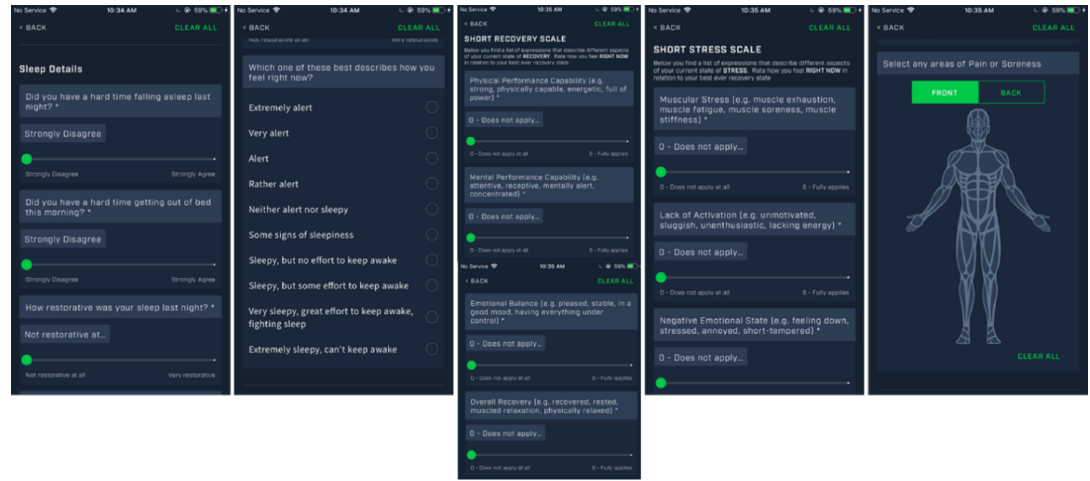
Figure 2. COVID-19 Monitoring and Symptom Daily Questions.